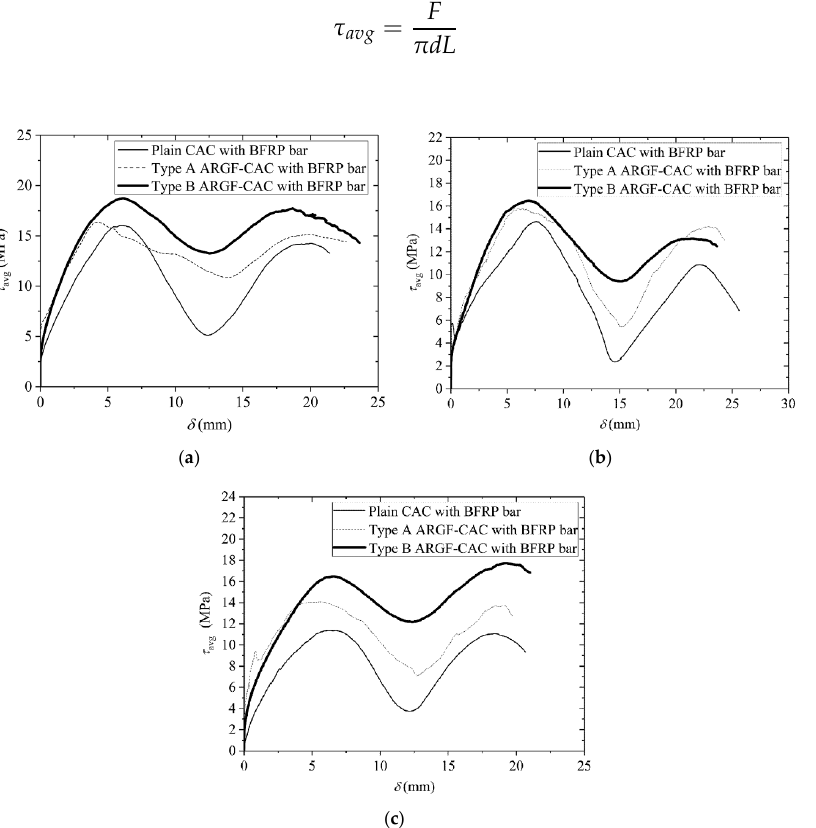
Figure 18. τ avg - δ curves for BFRP bar: ( a ) L = 5 d ; ( b ) L = 7.5 d ; and, ( c ) L = 10 d.